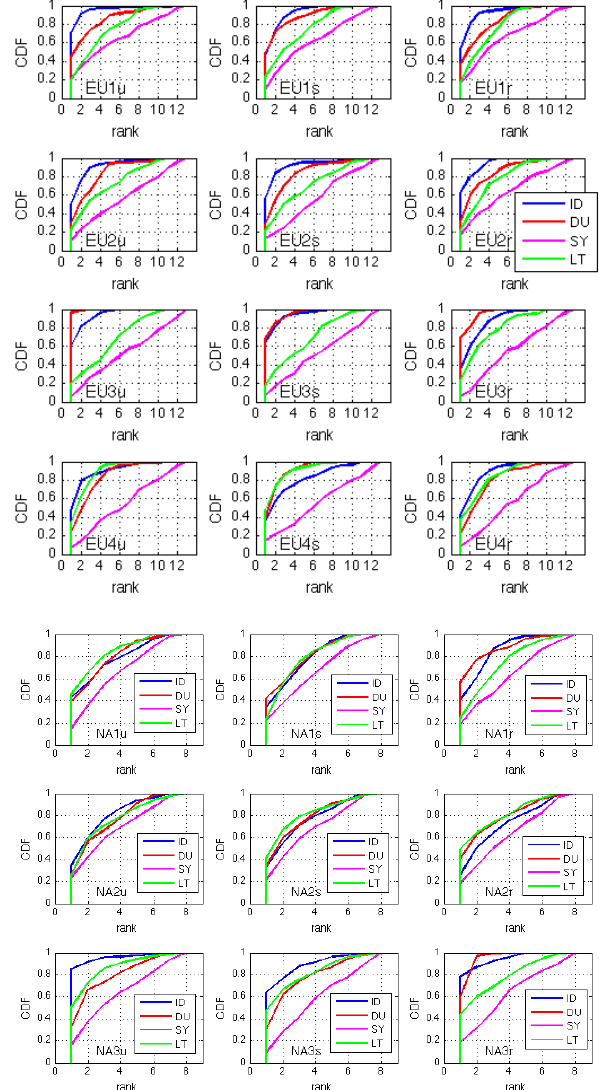
Fig. 12. The Cumulative density function of the actual rank (vali- dated against observations) of the selected models in the PREDICT week ( F -step). In diagnostic (hindcast) mode, we only have rank 1. The persistence assumption for the best modelled spectral compo- nents is strong for ID, DU and LT (in this order) and weaker for the SY